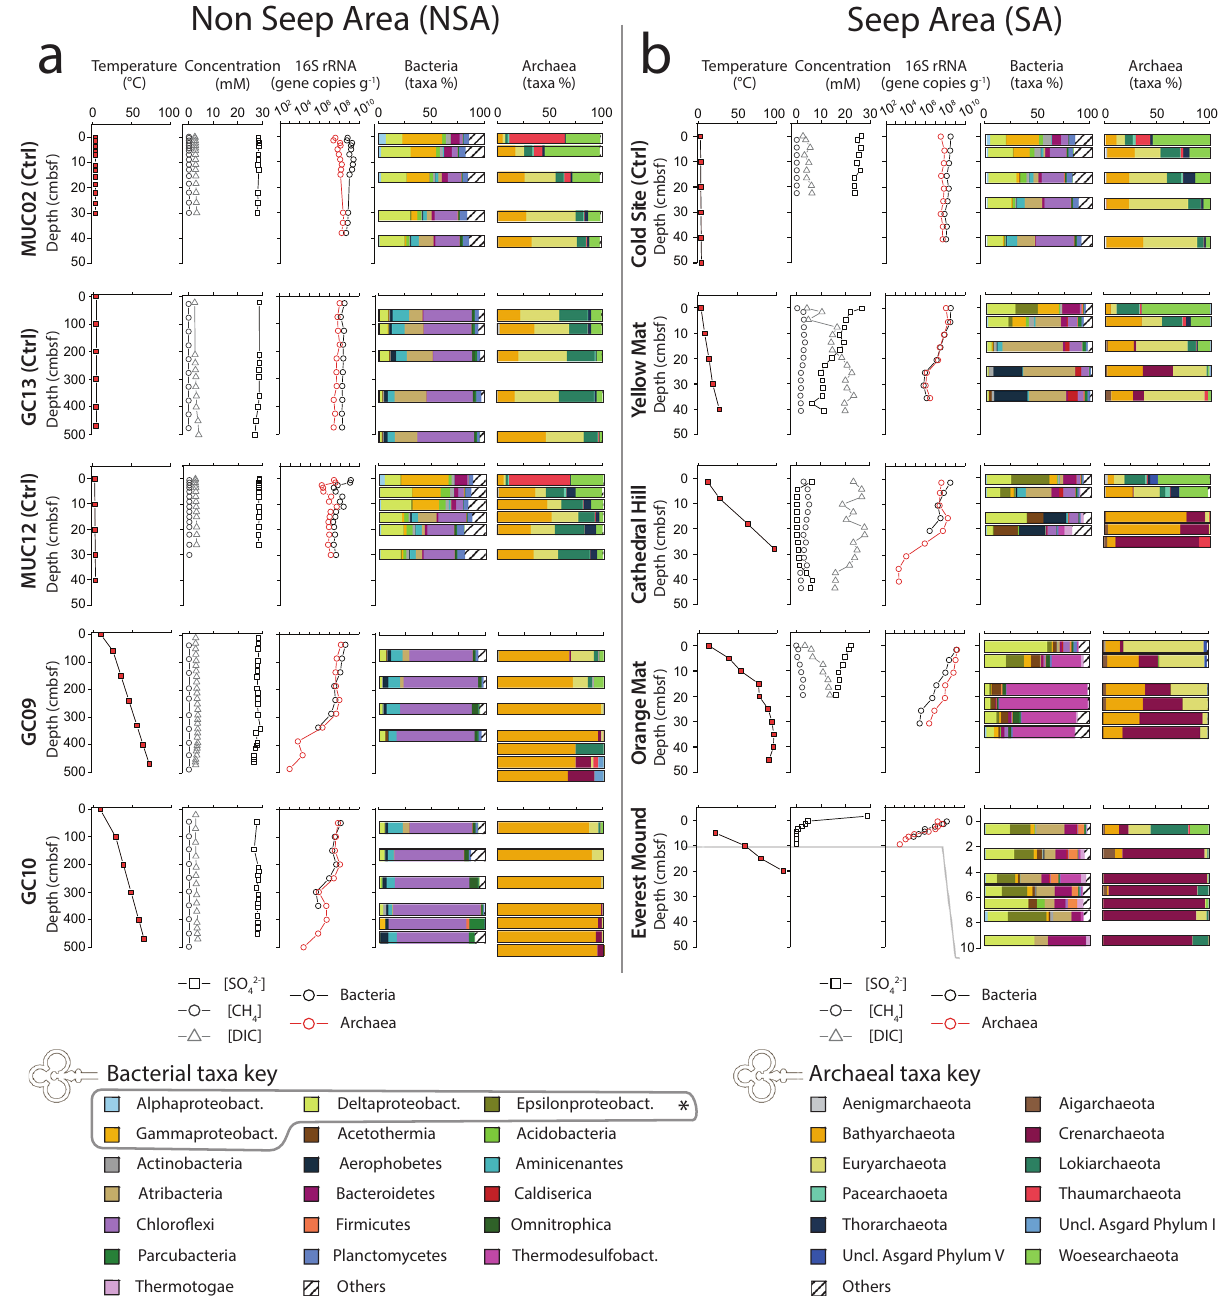
Fig. 1 Microbial abundance and community structure in relation to temperature and geochemical gradients. Depth pro fi les of temperature (1st column), porewater dissolved sulfate, methane, and dissolved inorganic carbon (DIC) concentrations (2nd column), bacterial and archaeal 16S rRNA gene abundances (3rd column), bacterial (4th column) and archaeal community structure (5th column) across the 10 study sites. a Sites from the NSA. b Sites from the SA. Bacteria and Archaea community structure is shown at the phylum level, except in Proteobacteria, which are displayed at the class level (see asterisk). To improve visibility, we adjusted the depth axis range for bacterial and archaeal communities at Everest Mound, only showing the top 10 cm, where microbial 16S rRNA genes were above detection. Sulfate and methane data from the NSA, except those from MUC12, were previously published 27